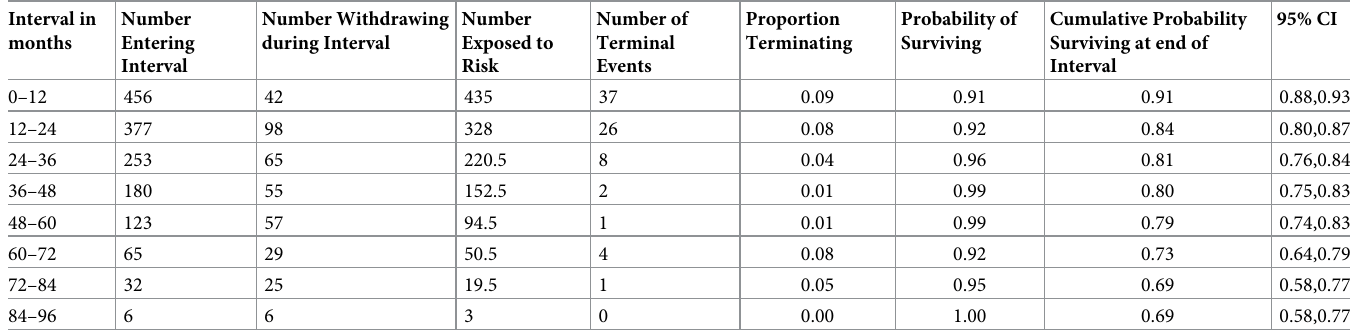
Table 5. Life table for adverse drug reaction survival among adult HIV positive patients in Arba Minch town public health facilities, southern Ethiopia 2020.